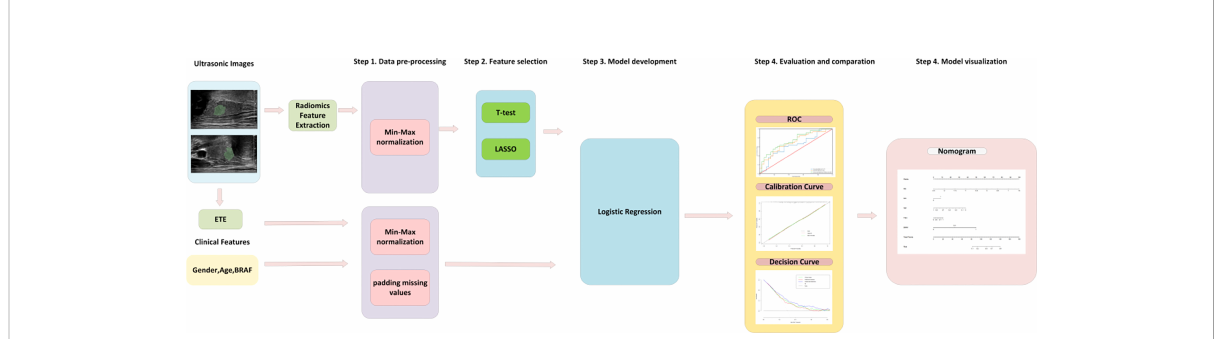
FIGURE 2 The fl owchart for model development, evaluation and visualization. First, the features were processed by normalization and padding the missing values. Second, radiomics features were selected by T test and the Lasso algorithm. Then, the logistic regression model was trained in